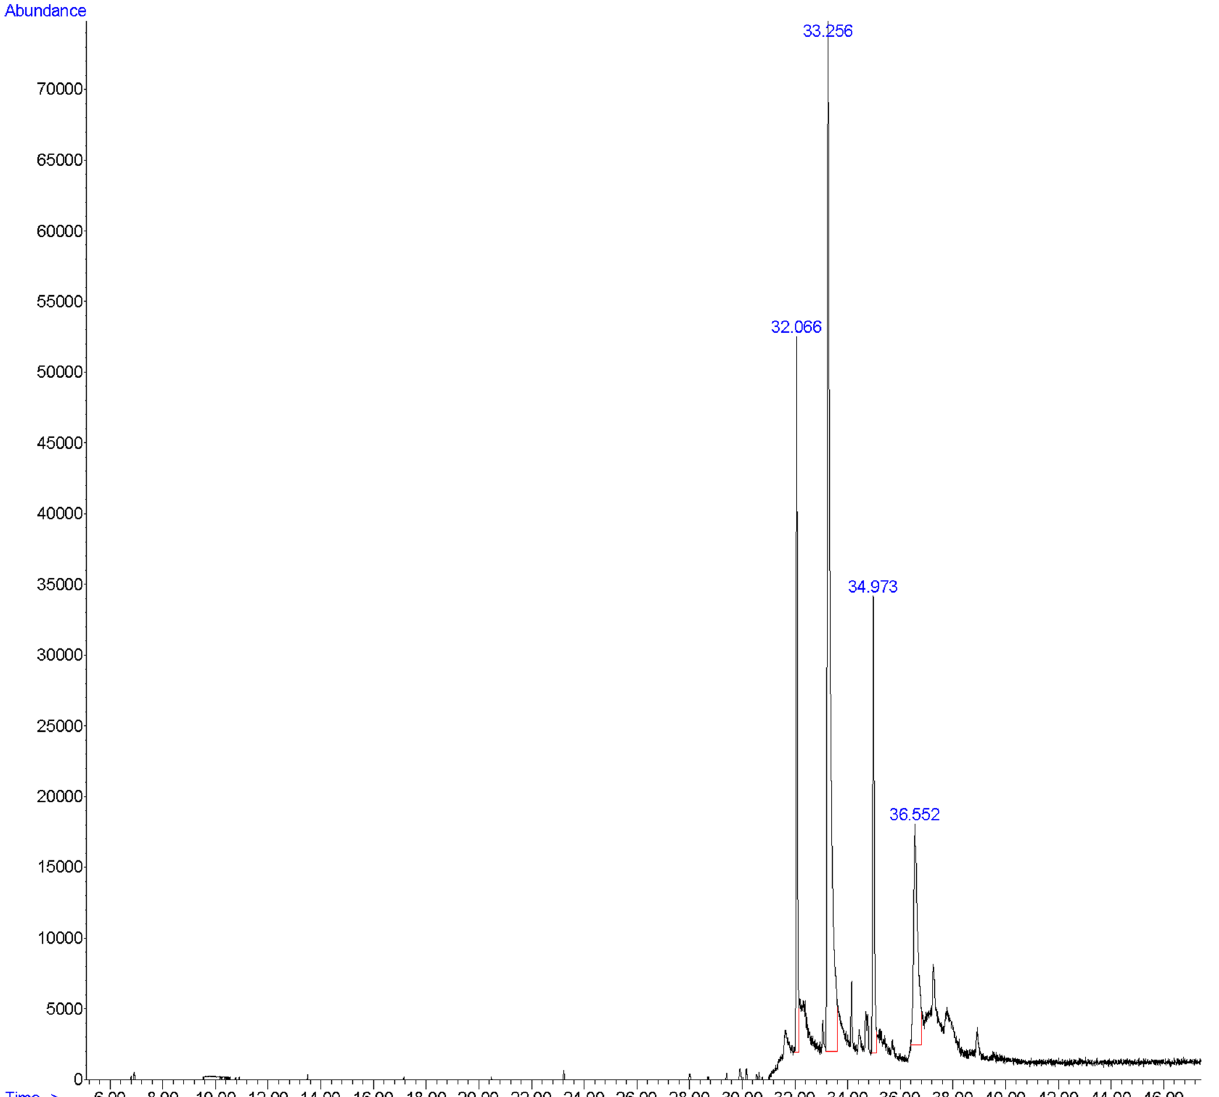
Figure 1. The GC–MS analysis of the propolis ethanolic extract. Sample peaks were detected as pinostrobin chalcone (32.066 s, 15.099% of total), galangin (33.256 s, 55.509% of total), tectochrysin (34.973 s, 13.216% of total), and naringenin (36.552 s, 16.177% of